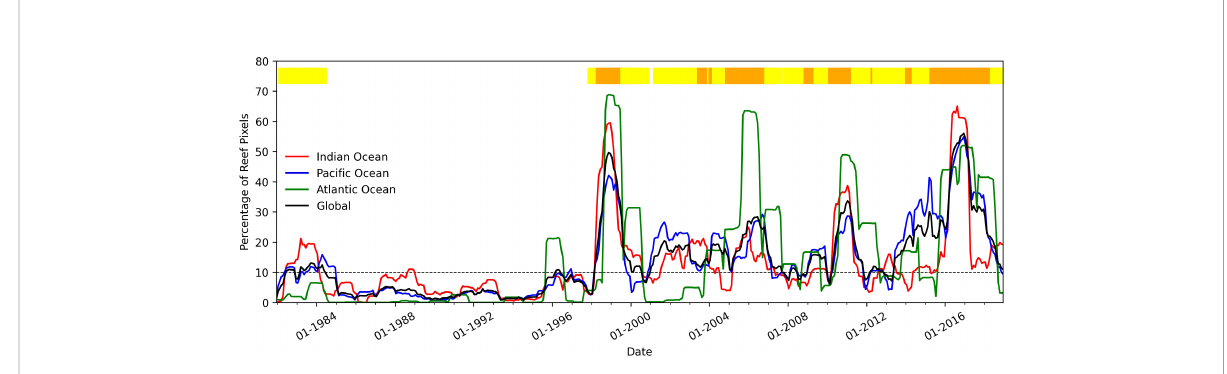
FIGURE 5 As for Figure 3 using an 8-month detection window applied to the 25-km OISST dataset for the period 1981-2018.